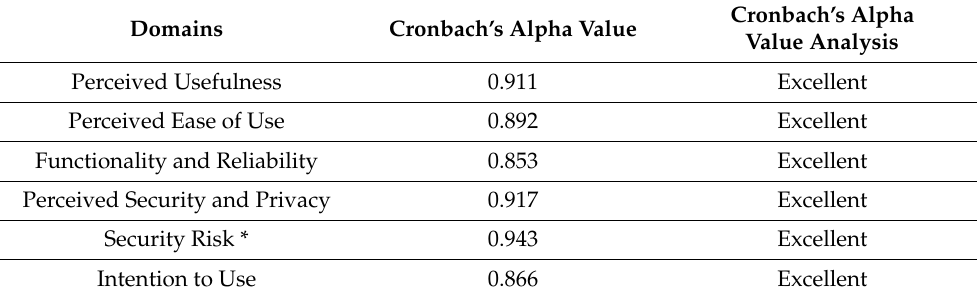
Table 5. Internal consistency of the domains.